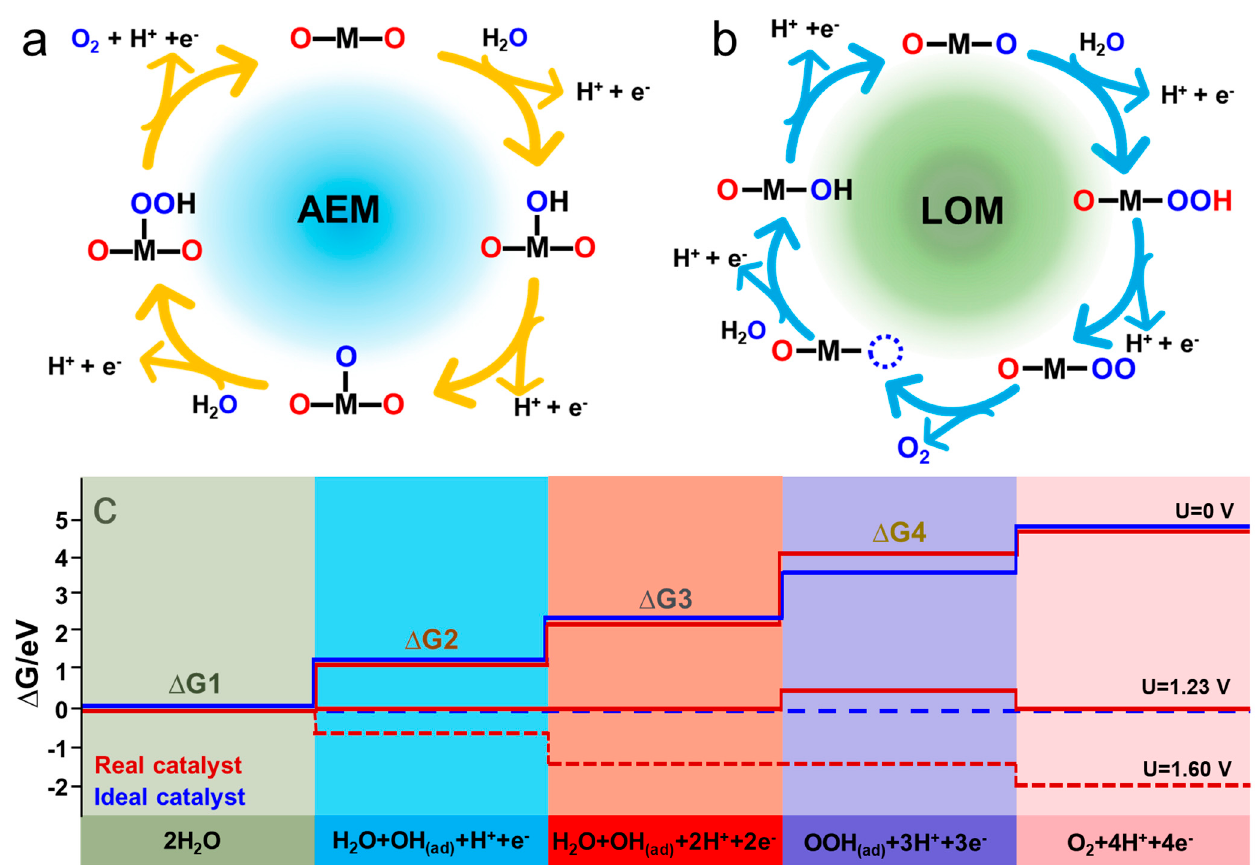
Figure 1. Mechanisms of OER. ( a ) Conventional AEM mechanism; ( b ) LOM mechanism (M represents the active sites); ( c ) Gibbs free energies at U = 0 for ideal and real electrocatalysts. Reproduced with permission of [17], copyright 2021 John Wiley and Son.